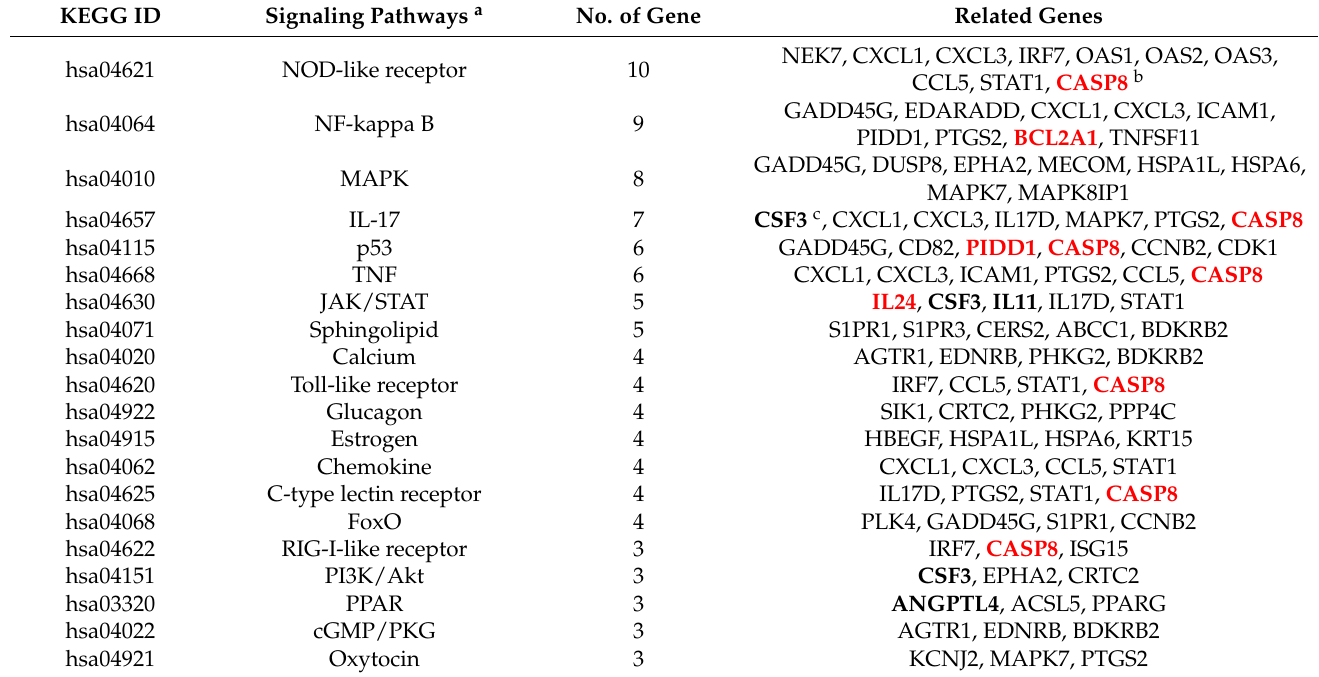
Table 1. Analysis of 412 genes involved in signaling pathways that showed altered expression by rCsGSTos under oxidative